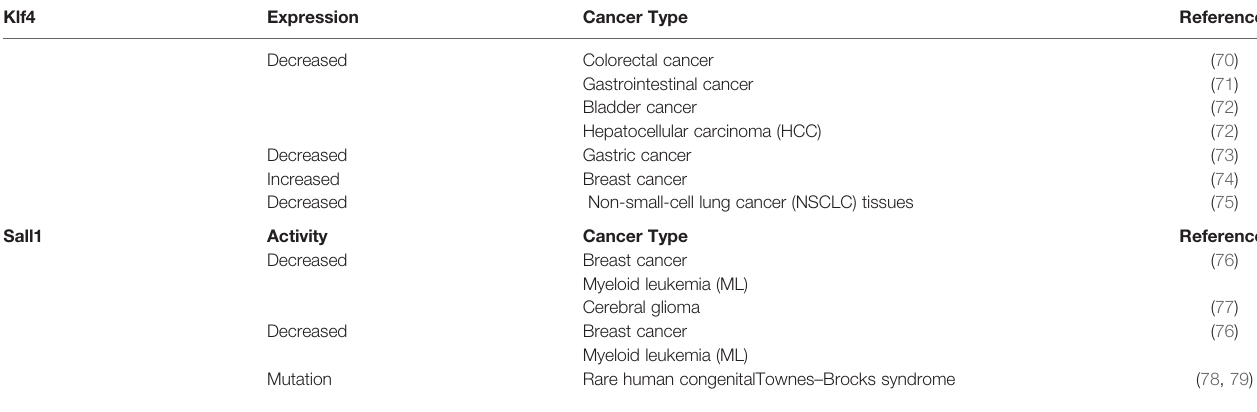
TABLE 2 | Expression of KLF4 and SALL1 in cancer suppression and carcinogenesis.